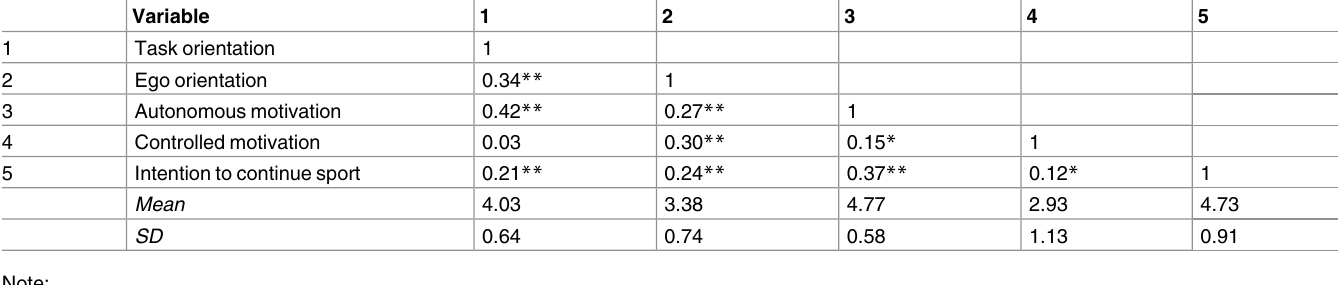
Table 1. Descriptivestatistics and the correlation matrix between